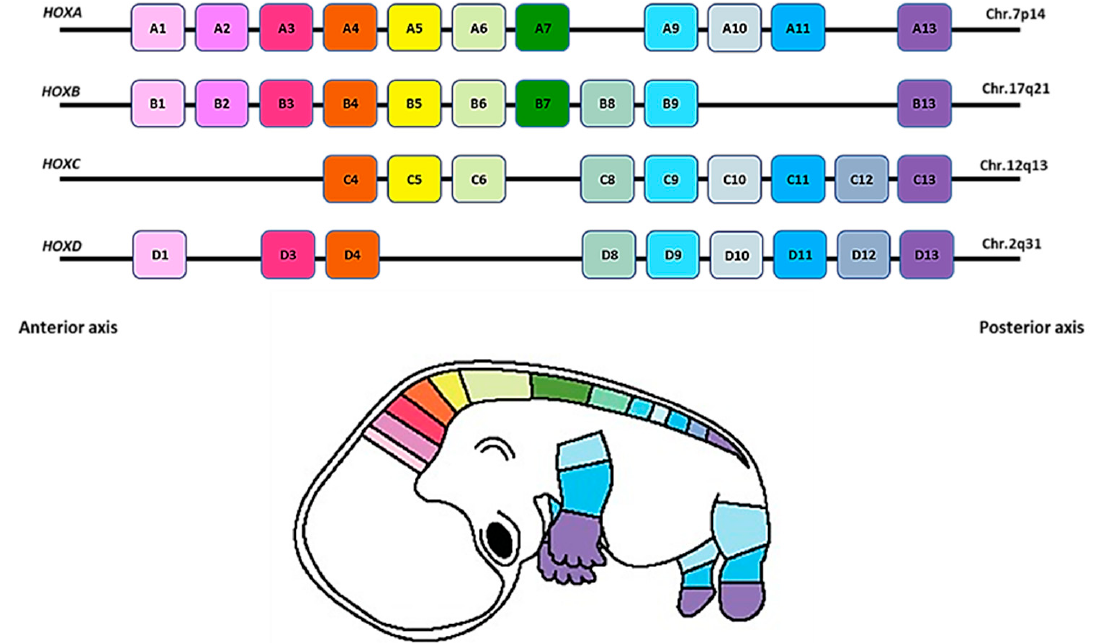
Figure 1. HOX genes in the human genome. Adapted from Durston et al. [8] The colour coding represents the correspondence between the genomic order of each HOX gene in the chromosomal cluster and the segmental identity in a human embryo (Microsoft PowerPoint software was used to create this figure).